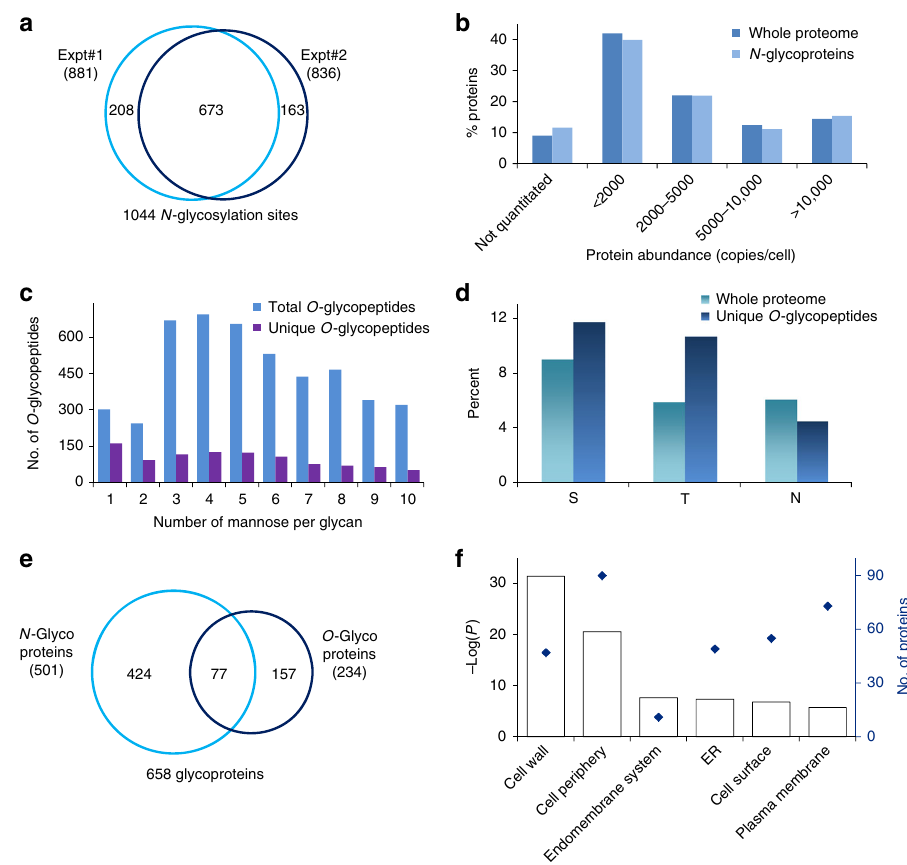
Fig. 4 Comprehensive analysis of protein N - and O -glycosylation in yeast. a Protein N -glycosylation sites identi fi ed in biological duplicate experiments. b Abundance distributions of the whole proteome (dark blue) and N -glycoproteins identi fi ed here (light blue). c Distribution of the number of mannose residues per glycan on all identi fi ed O -glycopeptides. d Percentages of S, T, and N in O -glycopeptides compared to the whole proteome. e Comparison of O - and N -glycoproteins identi fi ed in yeast cells. f Clustering of O -glycoproteins based on the cellular compartment. P values are calculated by a modi fi ed Fisher ’ s exact test